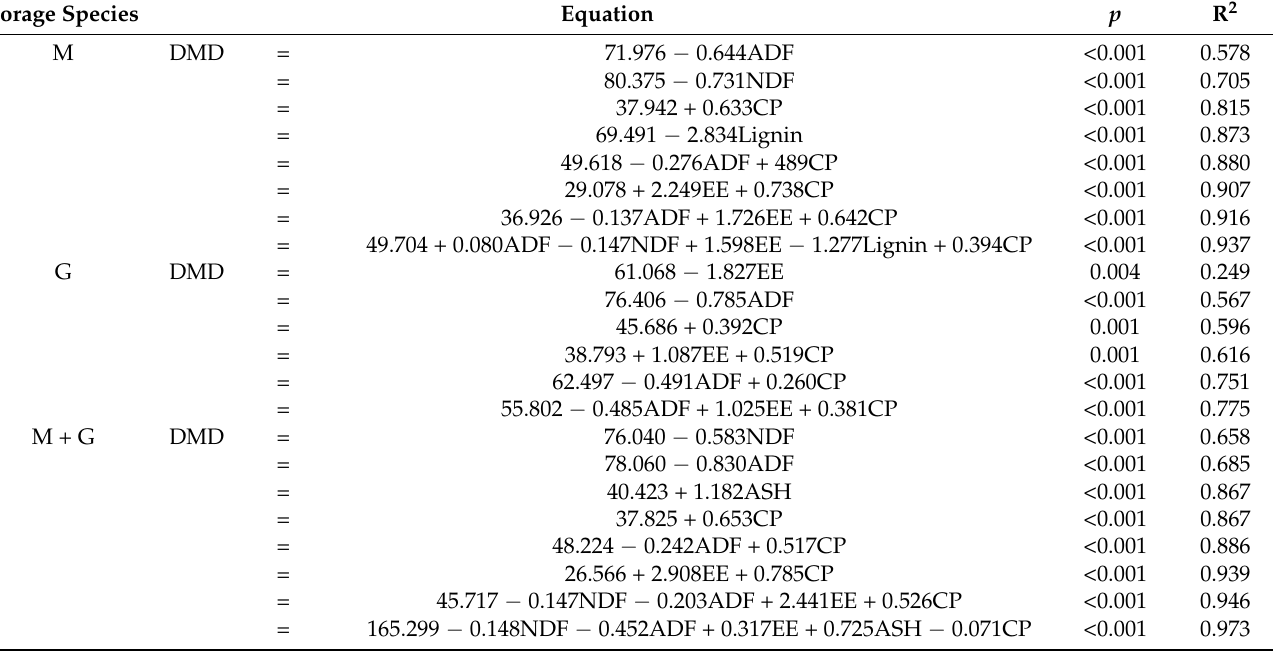
Table 1. Prediction of forage digestibility using forage nutrient content.